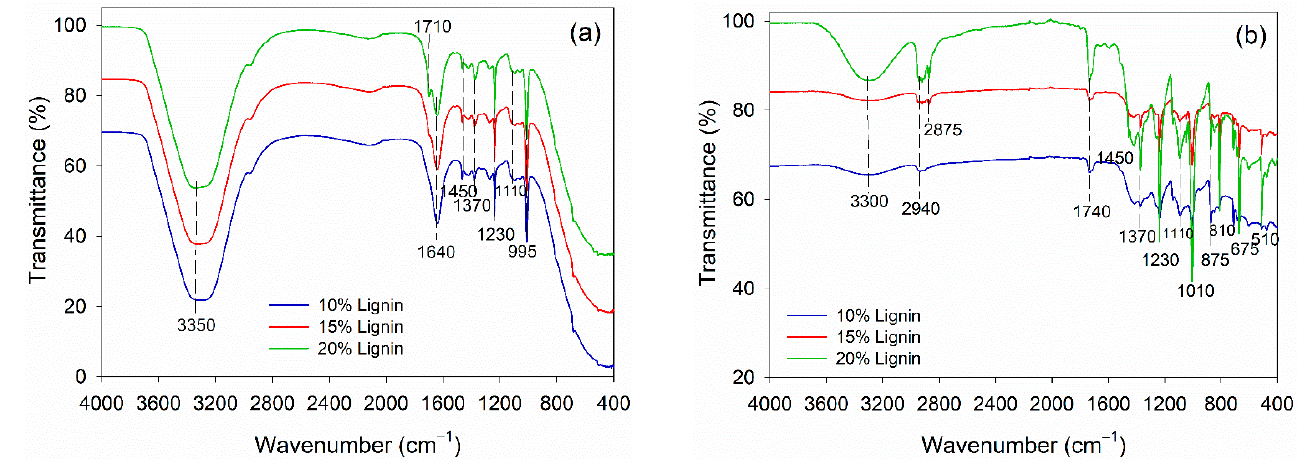
Figure 4. FTIR spectra of PVOH–lignin–hexamine blends with different lignin contents: ( a ) liquid adhesive, ( b ) cured adhesive.